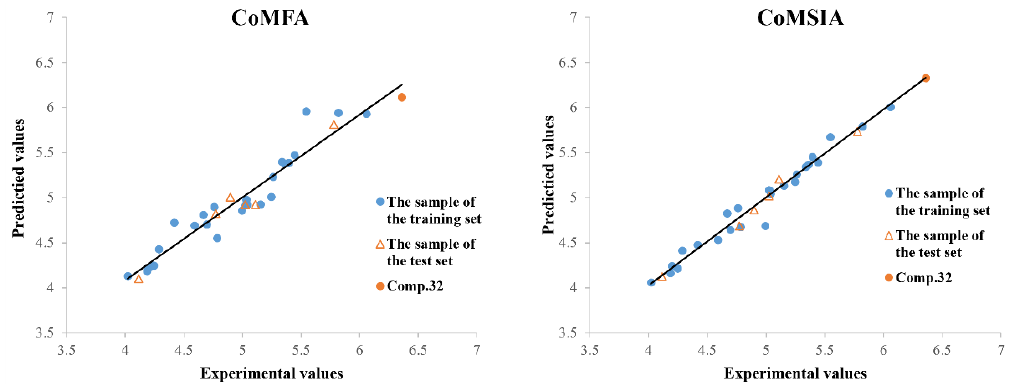
Figure 3. Plots of experimental and predicted pLC 50 for the CoMFA and CoMSIA models of 3D- QSAR.